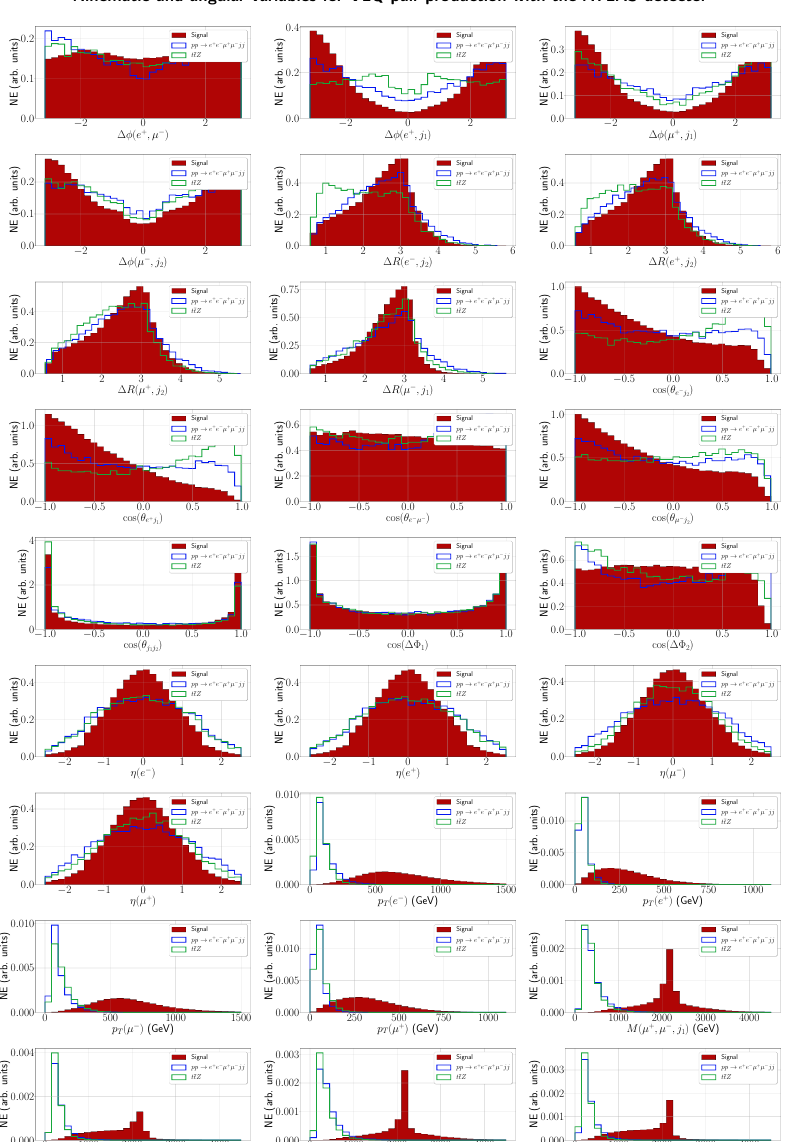
Figure 10. Set of angular and kinematic observables for VLQ pair-production with a mass m 2 . 2 TeV. All histograms are normalized, with each having 30 bins. Signal distributions are filled and shown in red, while background distributions are unfilled and shown in blue ( pp → e + e − µ + µ − j 1 j 2 ) and green ( t ¯ tZ ). From top-left to bottom-right, we have ∆ φ angles for final states combinations ( e + , µ − ) , ( e + , j 1 ) , ( µ + , j 1 ) and ( µ − , j 2 ) ; ∆ R distributions for the final states combinations ( e − , j 2 ) , ( e + , j 2 ) , ( µ + , j 2 ) and ( µ − , j 1 ) ; distributions of the cosine of the angle within the pair of states ( e − , j 2 ) , ( e + , j 1 ) , ( e − , µ − ) , ( µ − , j 2 ) and ( j 1 , j 2 ) ; distributions for the cosine of the angle ∆Φ 1 and ∆Φ 2 ; pseudo-rapidity for e − , e + , µ − and µ + ; transverse momentum for e − , e + , µ − , µ + and invariant mass distributions for the combinations ( µ + , µ − , j 1 ) , ( µ + , µ − , j 2 ) , ( e + , e − , j 1 ) and ( e + , e − , j 2 )